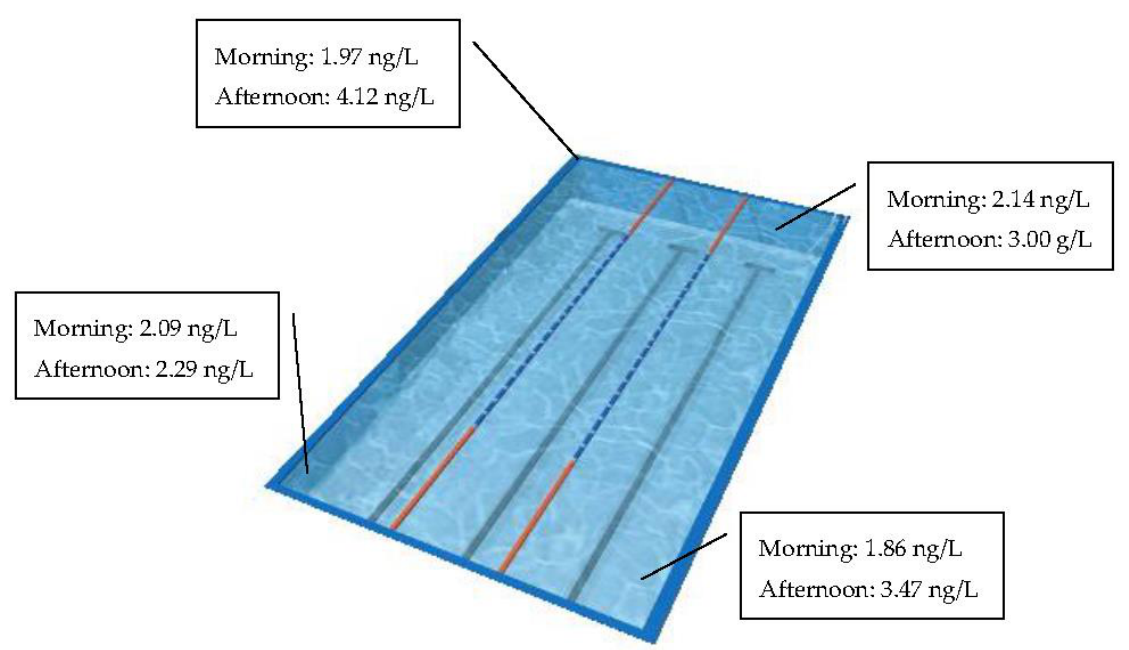
Figure 2. BP-3 concentrations depending on the point and time of sampling.